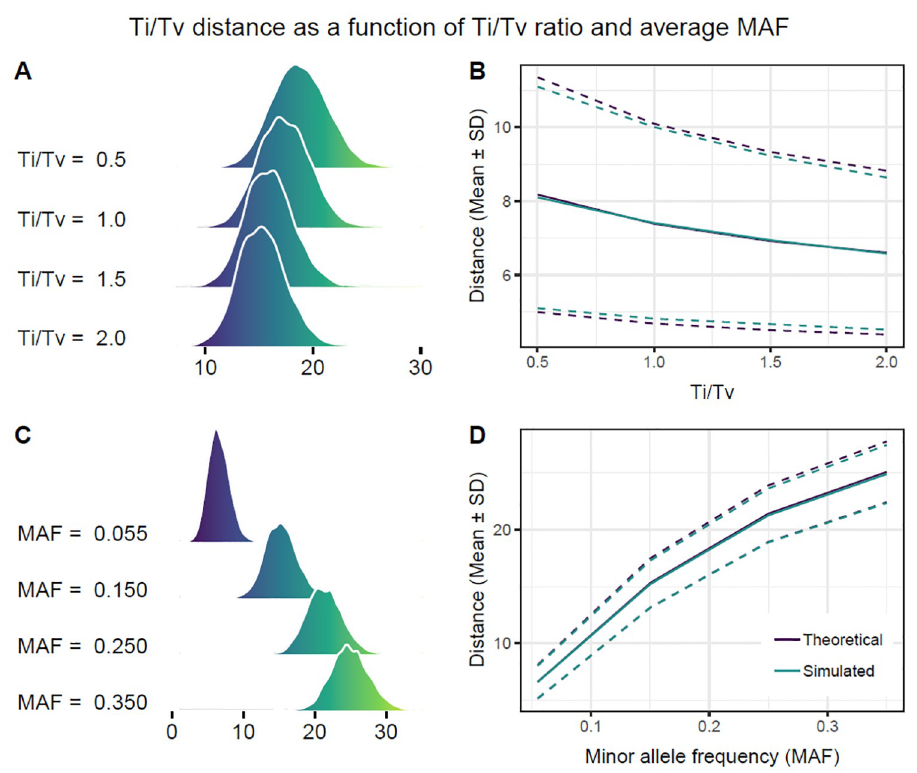
Fig 7. Density curves and moments of TiTv distance as a function of average MAF � f ratio η , given by Eq 127. We fix m = p = 100 for all simulated TiTv distances. ( A ) For fixed � f density is plotted as a function of increasing η . TiTv distance decreases as η increases. For η = Ti/Tv = 0.5, there are twice as many transversions as there are transitions. On the other hand, η = Ti/Tv = 2 indicates that there are half as many transversions as transitions. Since transversions encode a larger magnitude distance than transitions, this behavior is expected. ( B ) Simulated and predicted mean ± SD are shown as a function of increasing Ti/Tv ratio η . Distance decreases as Ti/Tv increases. Theoretical and simulated moments are approximately the same. ( C ) For fixed η = 2, TiTv distance density is plotted as a function of increasing � f of 0.5, which means that there is about the same frequency of minor alleles as major alleles. ( D ) Simulated and predicted mean ± SD as a function of increasing average MAF � f increases. Theoretical and simulated moments are approximately the